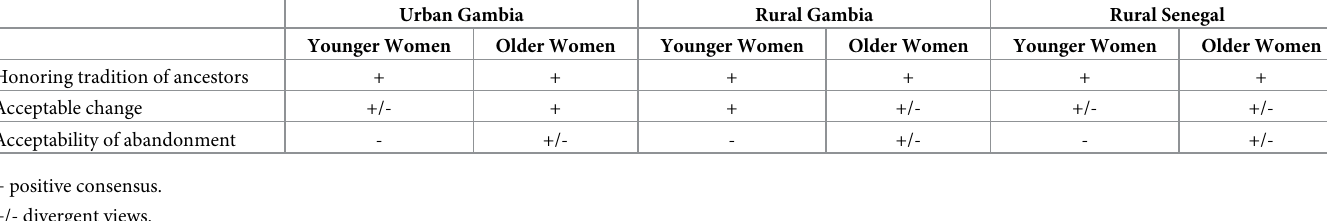
Table 2. Summary matrix of themes related to the overarching theme of